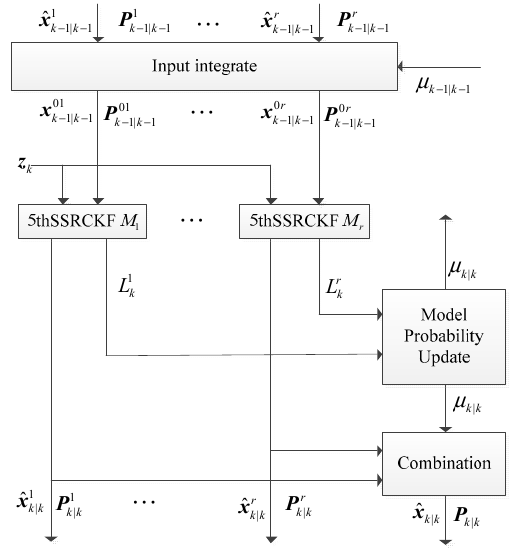
Figure 1. Structure of interacting multiple model fifth-degree spherical simplex-radial cubature Kalman filter (IMM5thSSRCKF).